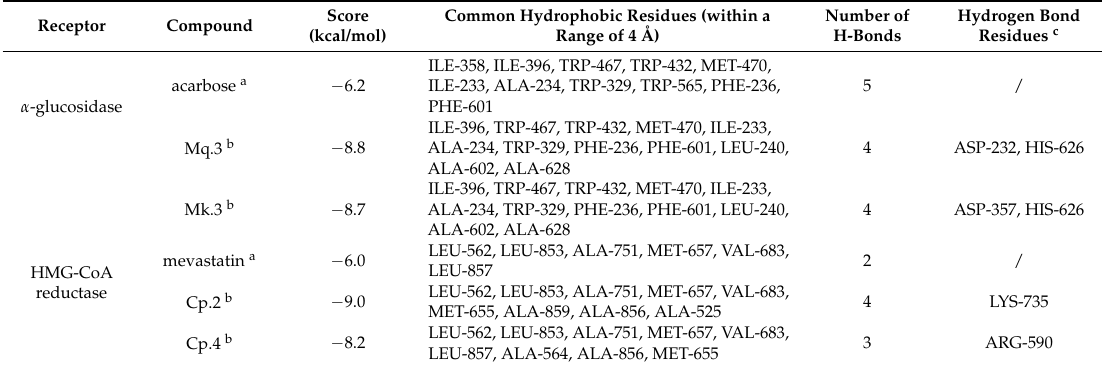
Table 2. Analysis of the conformation of good inhibitors within the binding sites of the receptors. Common Hydrophobic Residues (within a Receptor Compound Range of 4